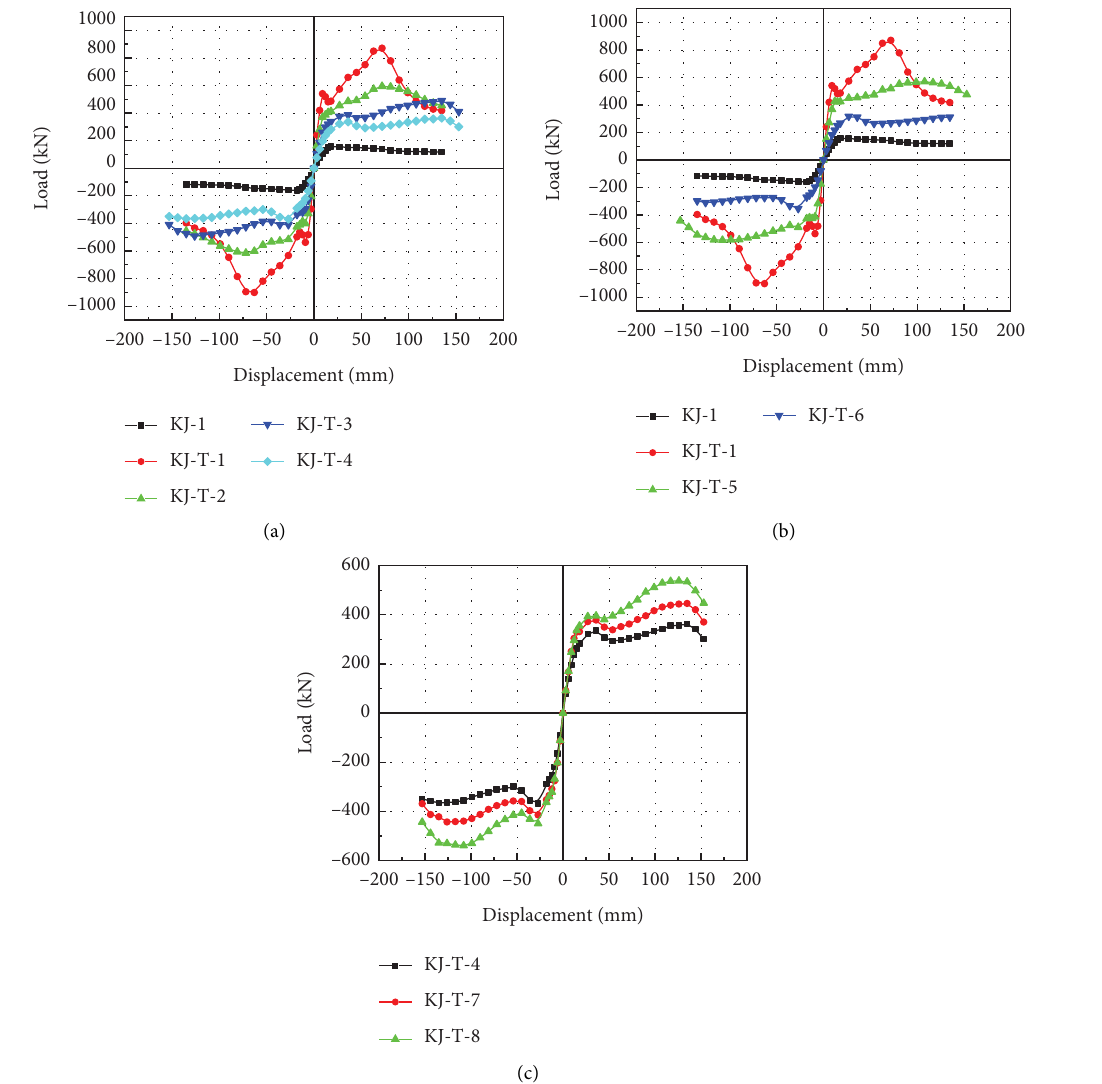
Figure 13: /e effect of different parameters on skeleton curves. (a) /e effect of opening rate. (b) /e effect of the infill falls position. (c) /e effect of the block